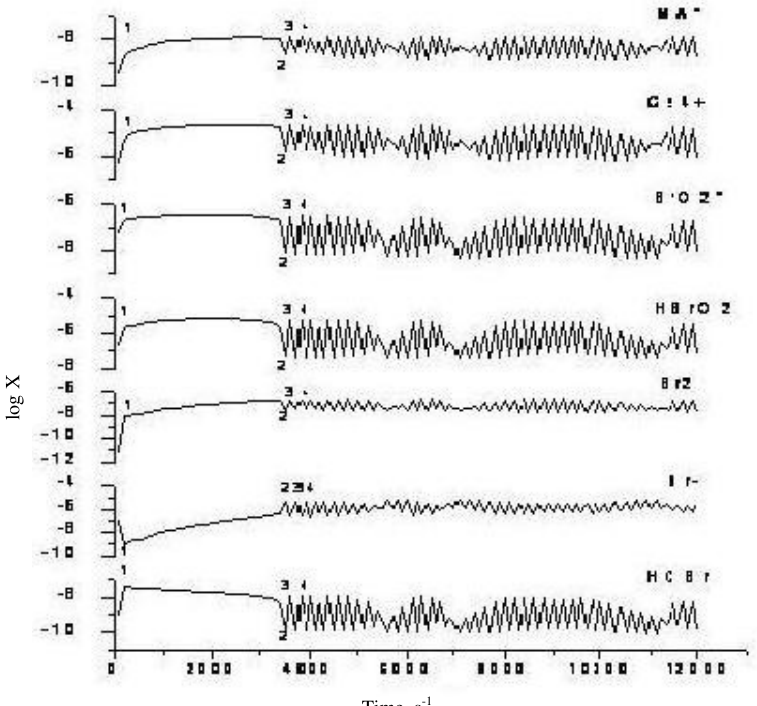
Figure 1 . Simulated plots of oscillations of different species at a flow rate of 3.071 x 10 - 4 s -1 with initial concentrations of all species at 1 X 10 -10 s -1 .The inflow concentrations [H M, [BrO 3- ]=0.1 M and [H + ]=0.26